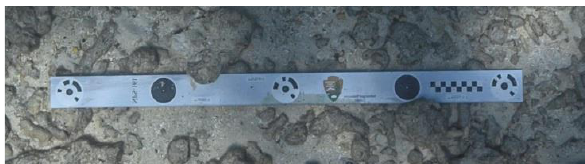
Figure 4. One of the three calibrated scalebar used for scaling the model.